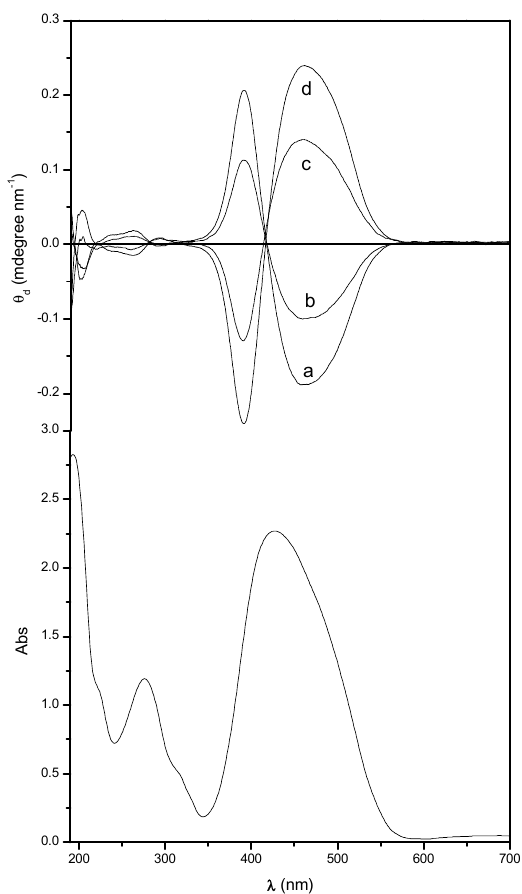
Figure 2. Bottom: UV-Vis spectrum of a 270 nm thick film of poly[( S )- MAP-C ]. Up: CD spectra (normalized by the film thickness) of poly[( R )- MAP-C ] (a); copol ( R )-75 (b); copol ( S )-75 (c) and poly[( S )- MAP-C ] (d) at the solid state.